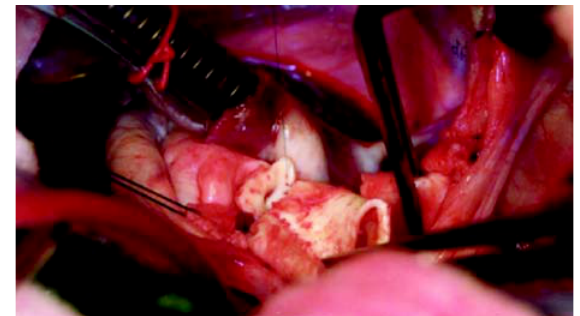
Fig. 2 – Reimplante dos óstios